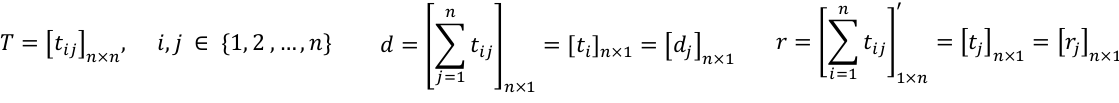
Significance and effectiveness of the criteria of internal environment indicators in the SWOT matrix Type of relationship